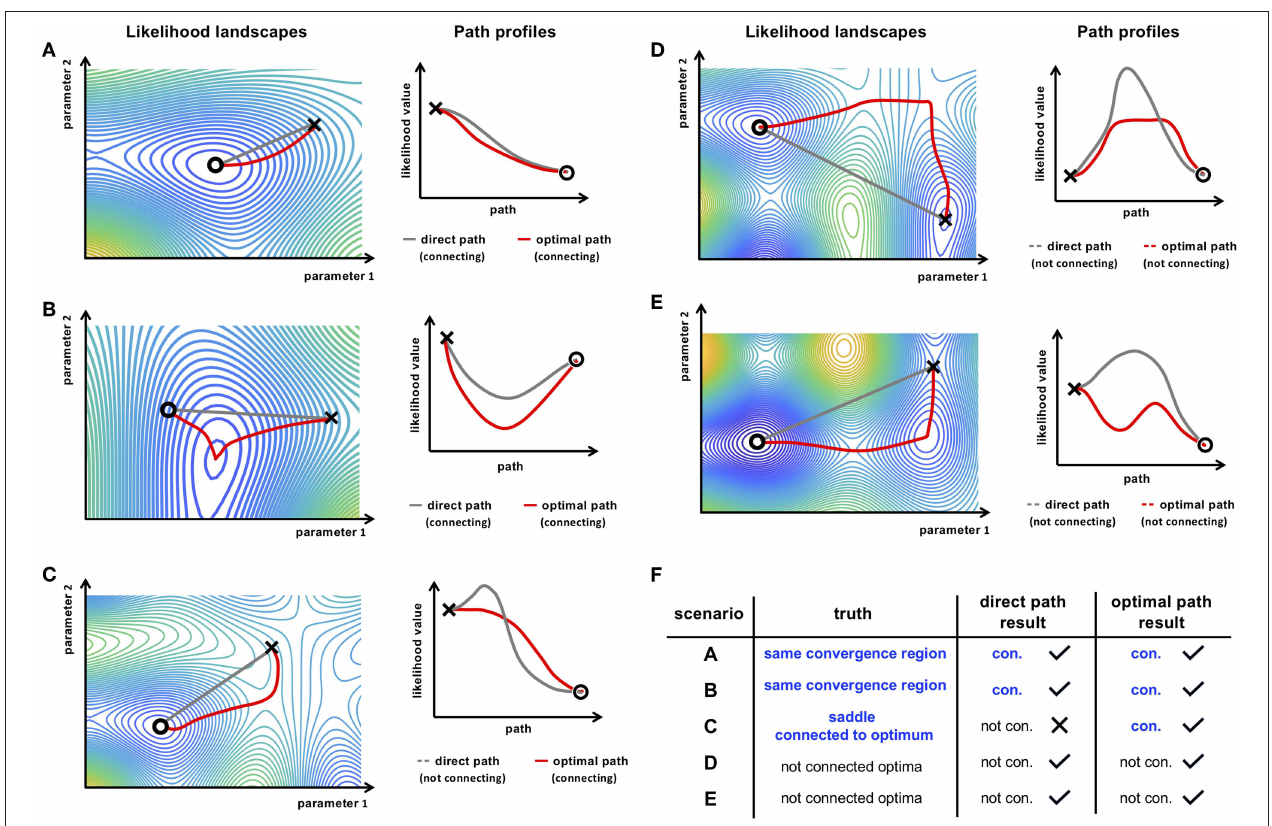
FIGURE 3 | (A–E) Illustrative likelihood landscape scenarios and their respective path profiles revealing connections between two points in the parameter space ( × and ◦ ). The gray line represents the direct path in the likelihood landscape and the respective path profile. The red paths show the outcome of an optimal path finding method, e.g., the NEB method. By this, more complex paths can be found, as for instance in scenario (C) , where a connection is denied by the direct path, but an appropriate path finding method reveals the monotonically decreasing connecting path. The table in (F) summarizes conclusions about connectivity of the two points in the respective scenarios. Only the optimal path method is able to adequately draw conclusions about the connectivity of the two